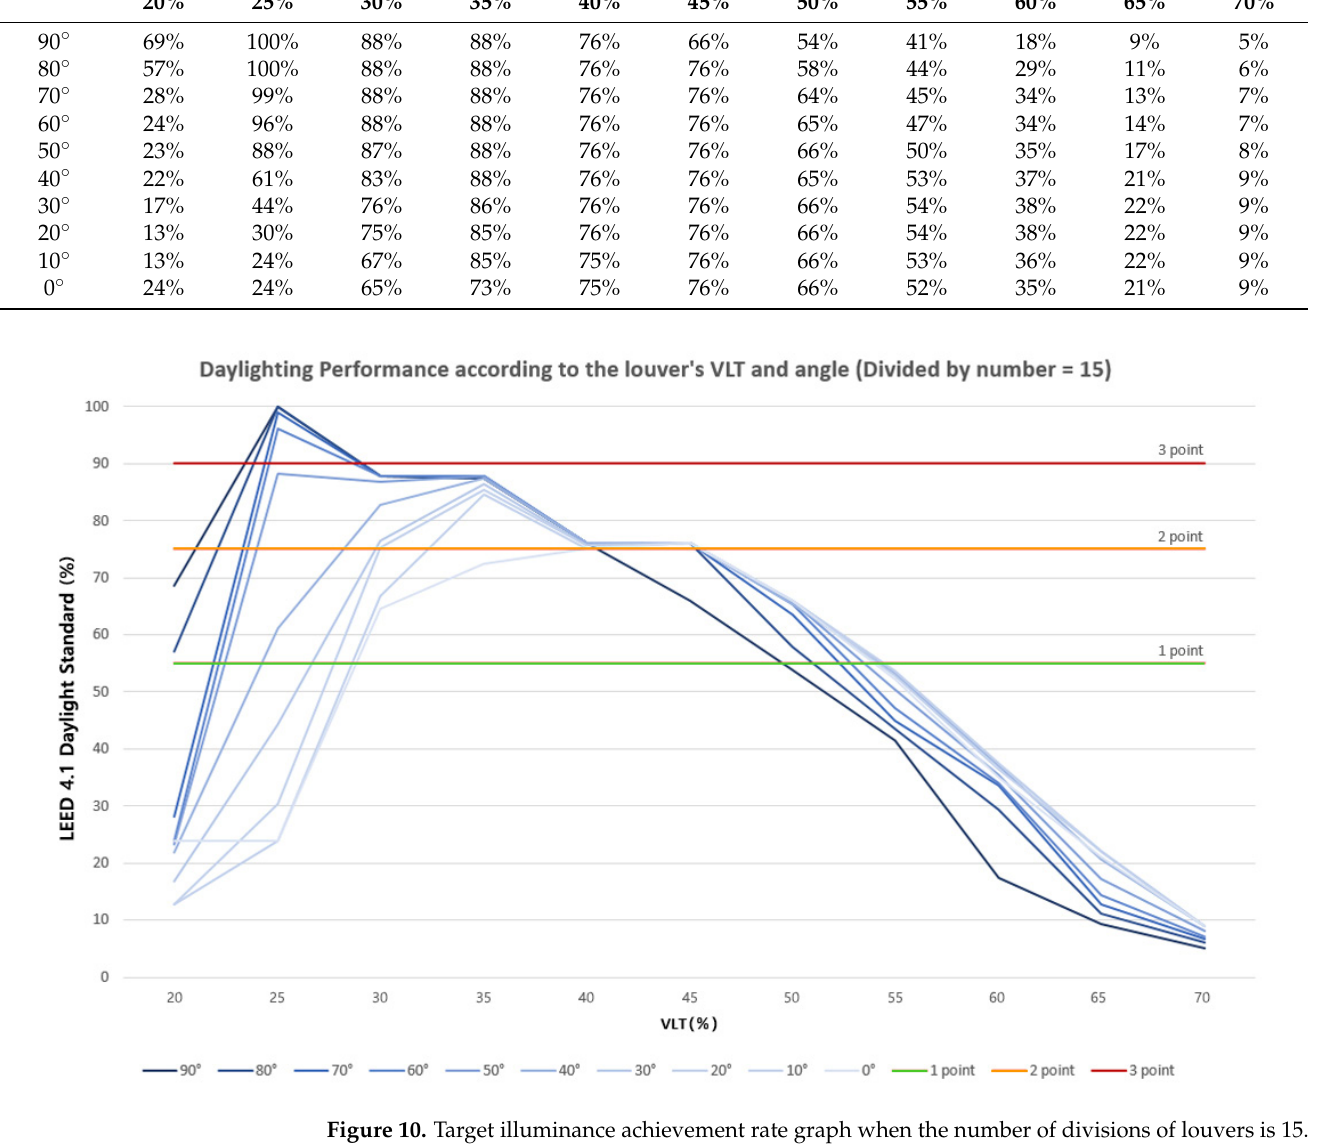
Figure 10. Target illuminance achievement rate graph when the number of divisions of louvers is 15.